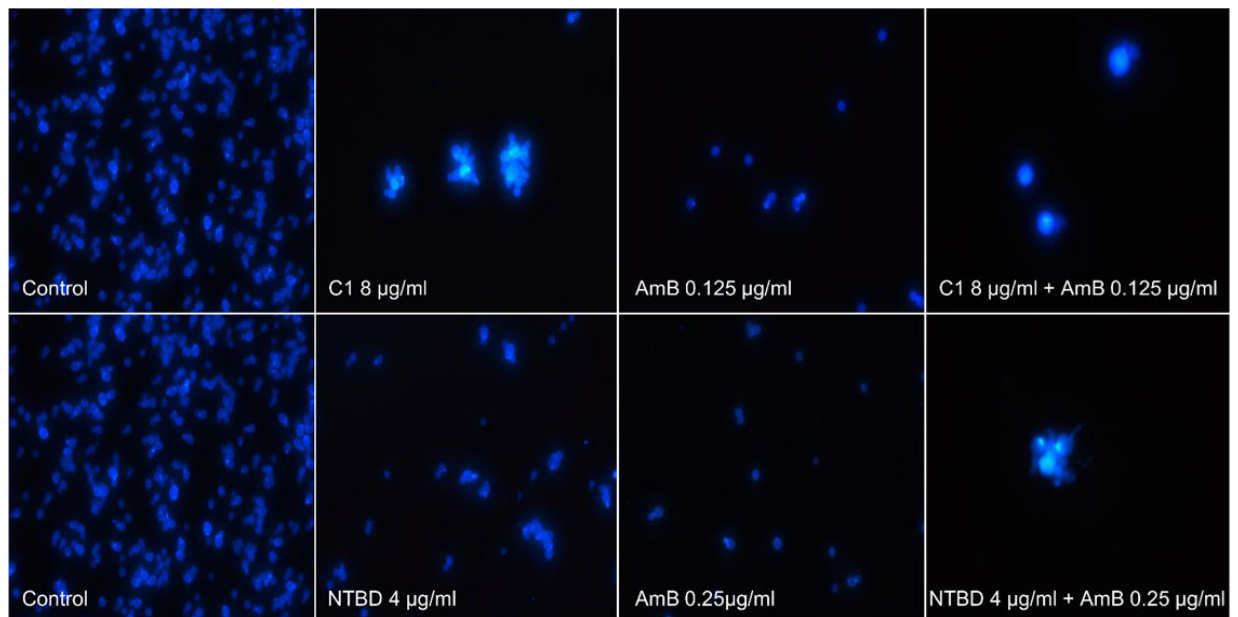
Figure 3. Fluorescence microscopy images showing morphological changes in Candida cells treated with C1 and NTBD separately and in combination with AmB at the selected concentrations. After 24 h of culture, the cells were stained with calcofluor white (magnification 600×).